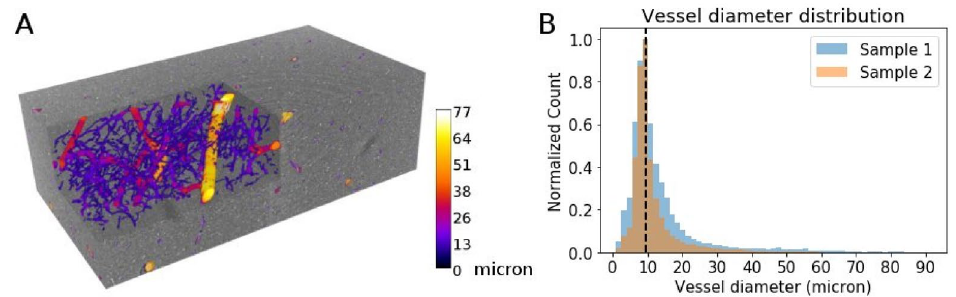
Figure 2. Microvasculature segmented from 0.94 µm voxel size phase-contrast microtomography. ( A ) The segmentation result from one of the regions of interest from sample 2. The vasculature is color-coded in terms of vessel diameter. The unit of the color bar is µm. The width, height and depth of the stack is 2.09 mm, 1.14 mm and 0.66 mm, respectively. ( B ) Vessel diameter distribution from the two samples. The black dashed line indicates the center of the most frequent bin.